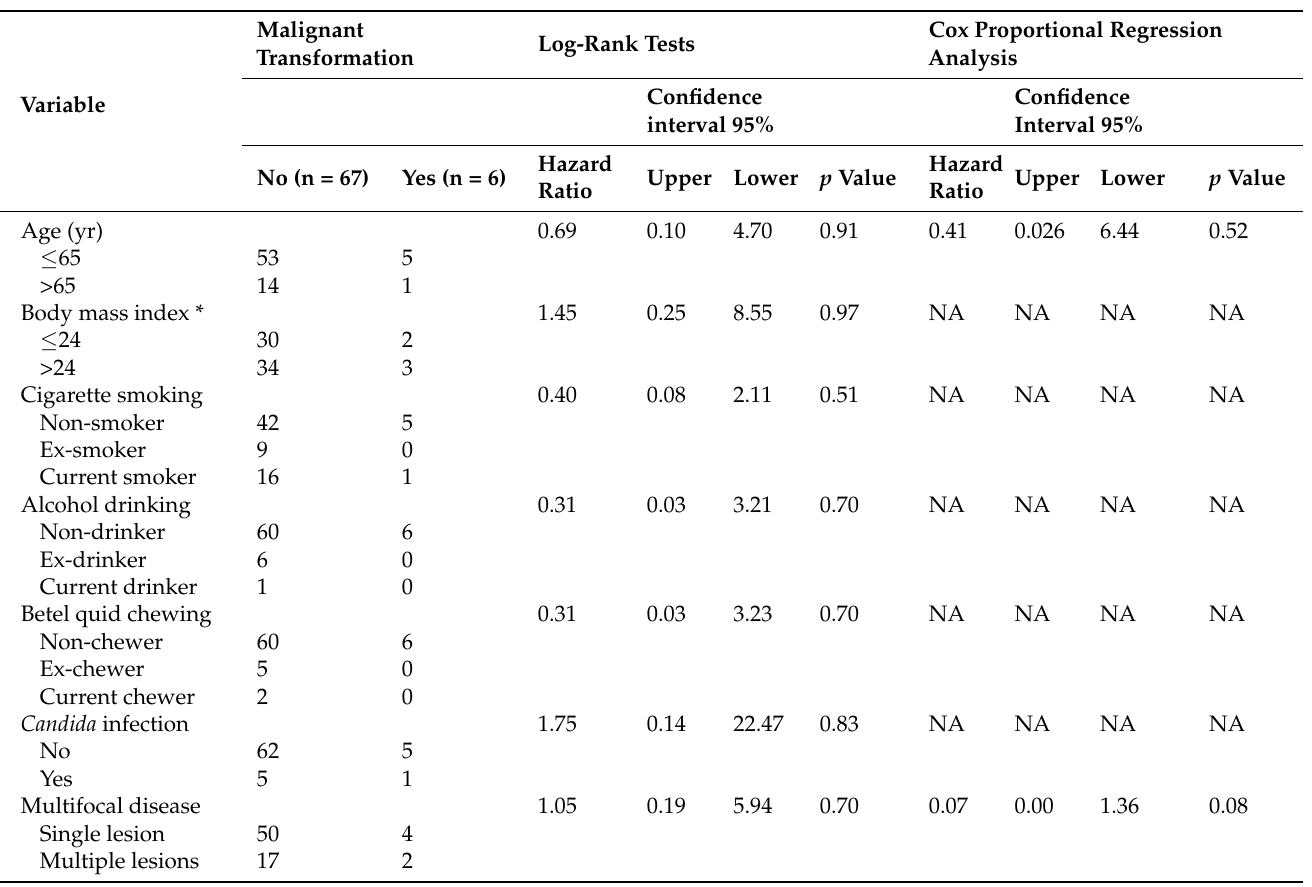
Figure 2. The receiver operating characteristic (ROC) curve analysis was used to predict postoperative recurrence. Each point on the ROC corresponds to a value on the area of oral leukoplakia. Table 4. Log-rank tests and Cox proportional regression analysis of postoperative malignant transformation (n = 6) in female patients who received laser surgery for oral leukoplakia (n =